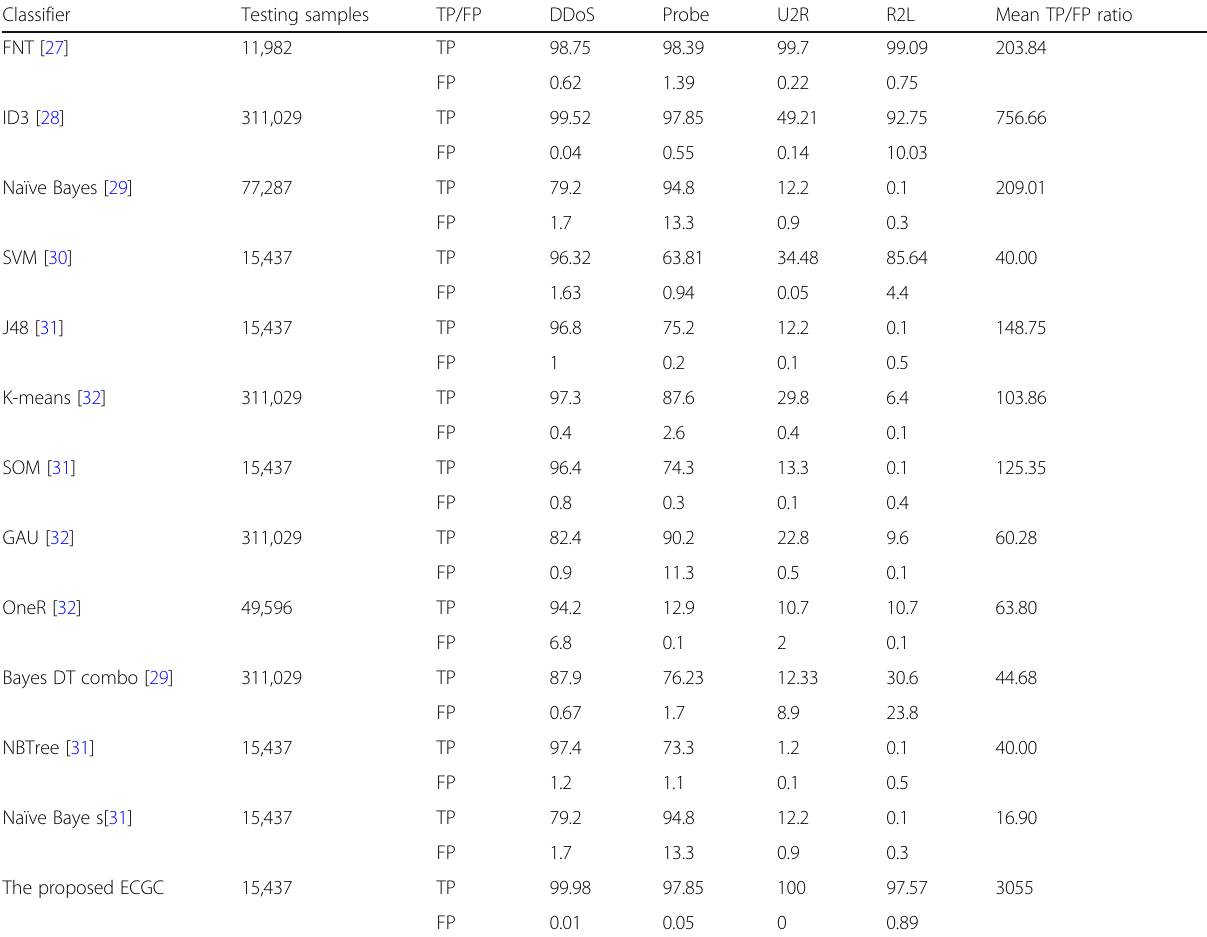
Table 6 Comparison results for the 10% KDD Cup 99 dataset Classifier